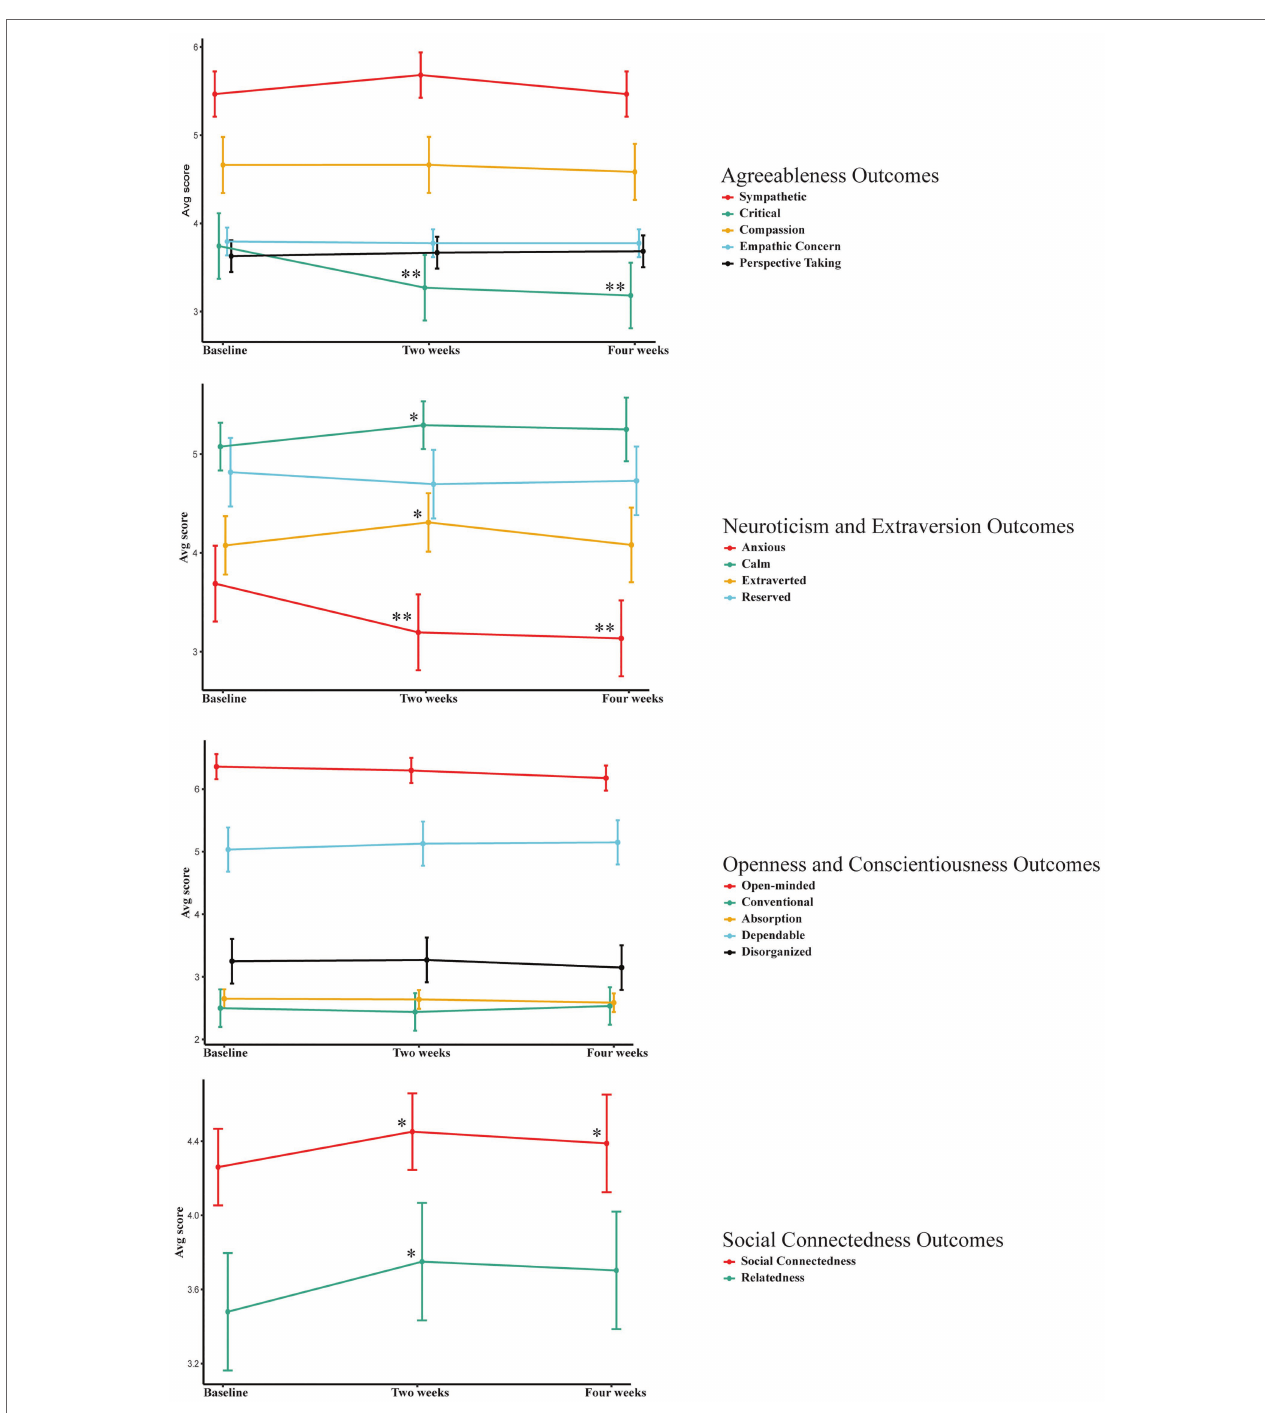
FIGURE 1 | Line plots illustrating change in outcomes. Error bars represent 99% confidence intervals around means for hypothesized outcomes including Agreeableness, Neuroticism, Extraversion, and Social Connectedness; and 99.5% confidence intervals around means for Conscientiousness and Perspective Taking. First and second sets of asterisks denote a significant difference between baseline and 2 weeks and 4 weeks, respectively, following psychedelic experience. * p < 0.01; ** p <